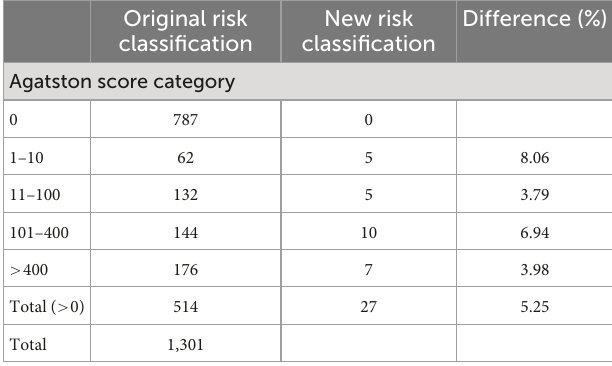
TABLE 4 Reclassification study for simulated PCD-CT examinations. Original risk